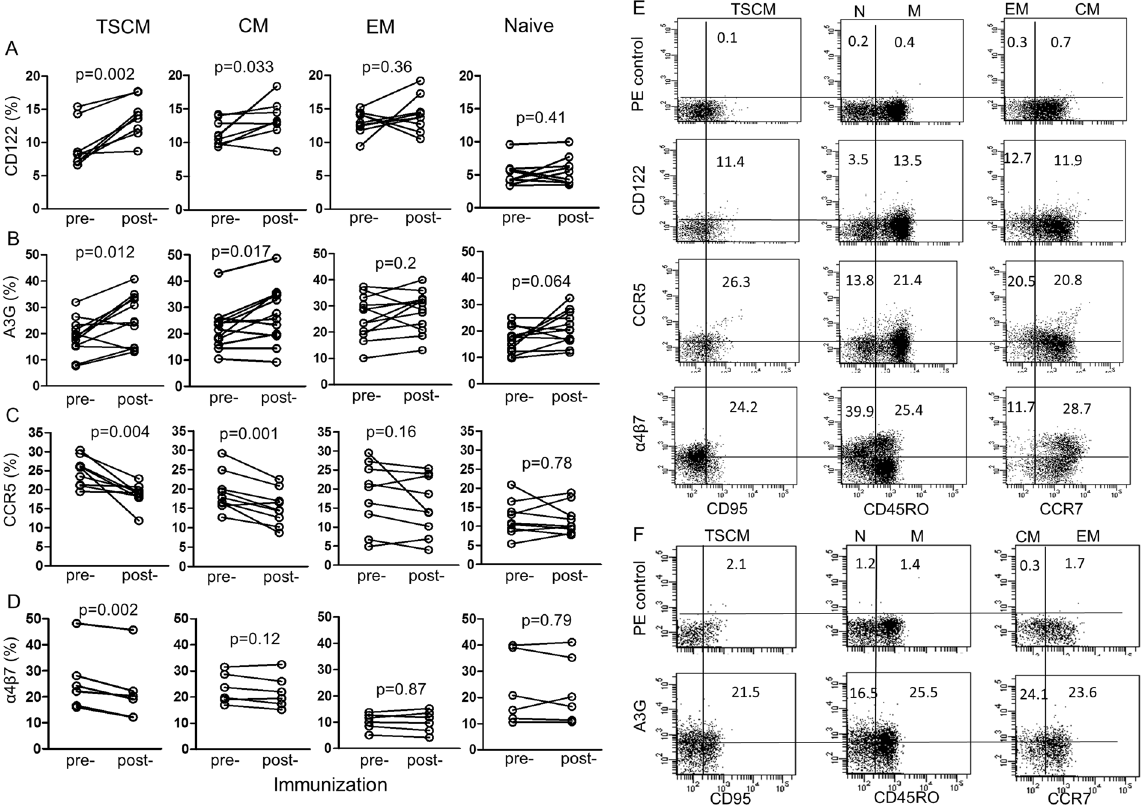
Figure 2. The effect of vaccination on the expression of ( A ) CD122, ( B ) A3G, ( C ) CCR5 and ( D ) intracellular α 4 β 7 in CD4 + TSCM, central, effector memory and naive CD4 + T cells, before and 28 weeks after the last vaccination (n = 9, except ( B ) n = 12) from different subjects. However, the comparison between the different memory and naïve cells was with the same 9 samples). ( E , F ) Gating and identification of CD122, CCR5 α 4 β 7 and A3G TSCM